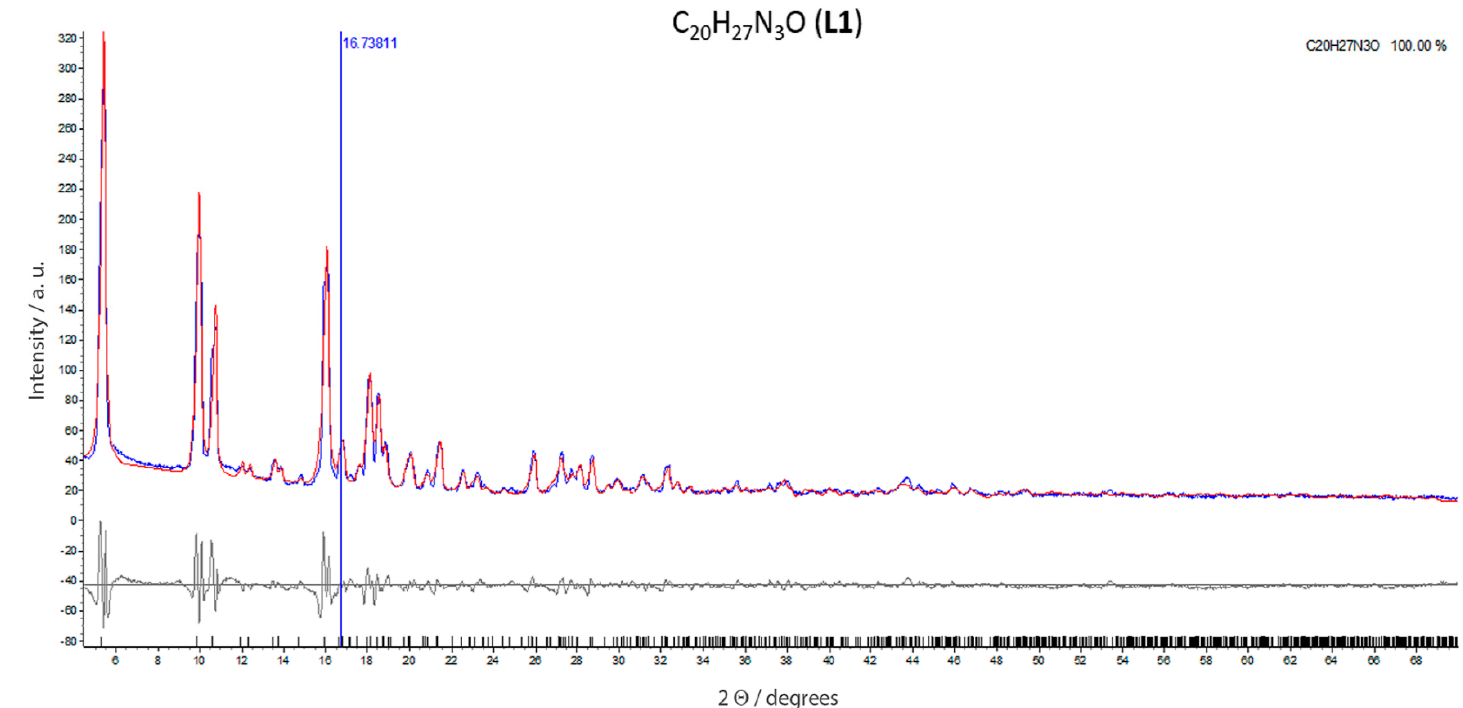
Figure 2. Pattern for L1 [( E )-2-{[(2-aminopyridin-2-yl)imino]-methyl}-4,6—di- tert -butyl-phenol]: The observed (red line) and calculated (blue line), and difference X-ray powder diffraction patterns (bottom), are shown. The difference pattern is plotted at the same scale as the other patterns up to 60° 2 θ . At higher angles, the scale has been magnified five times. Red line: experimental pattern; blue line: calculated pattern; gray line: difference between the calculated and experimental pattern.